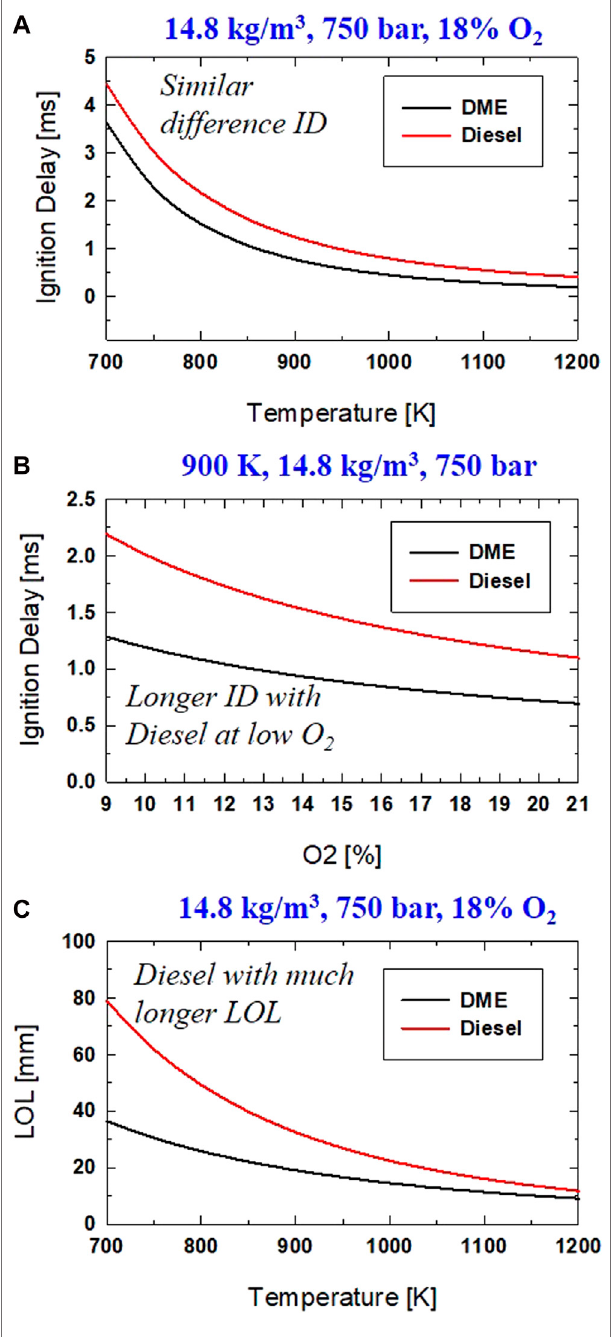
FIGURE 11 | Comparison of DME and Diesel for (A) Ignition delay at different T amb ; (B) Ignition delay at different O 2 , (C) LOL at different T amb .